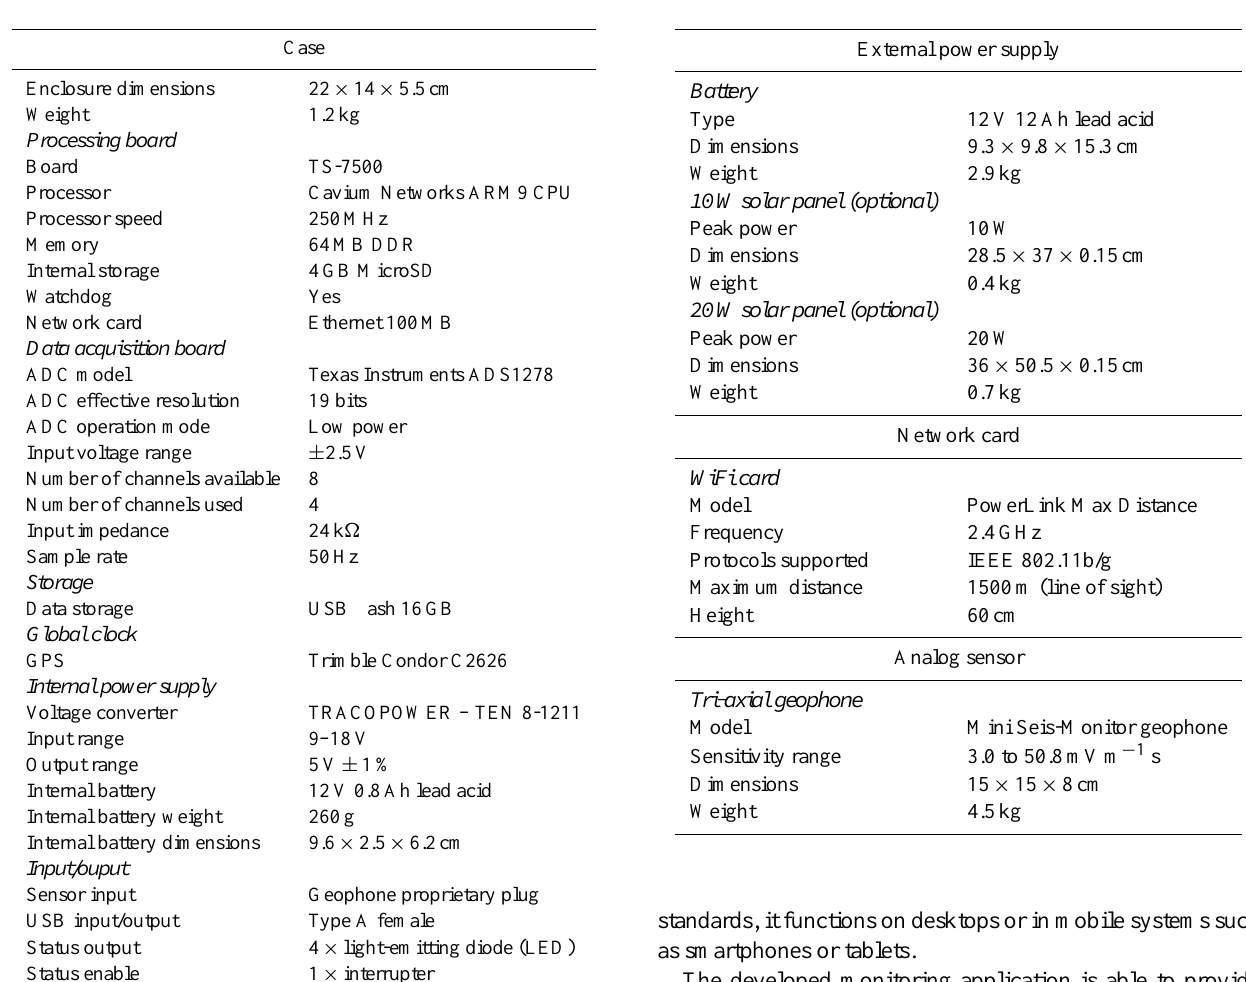
Table 1. Technical specification – case. Table 2. Technical specification – external